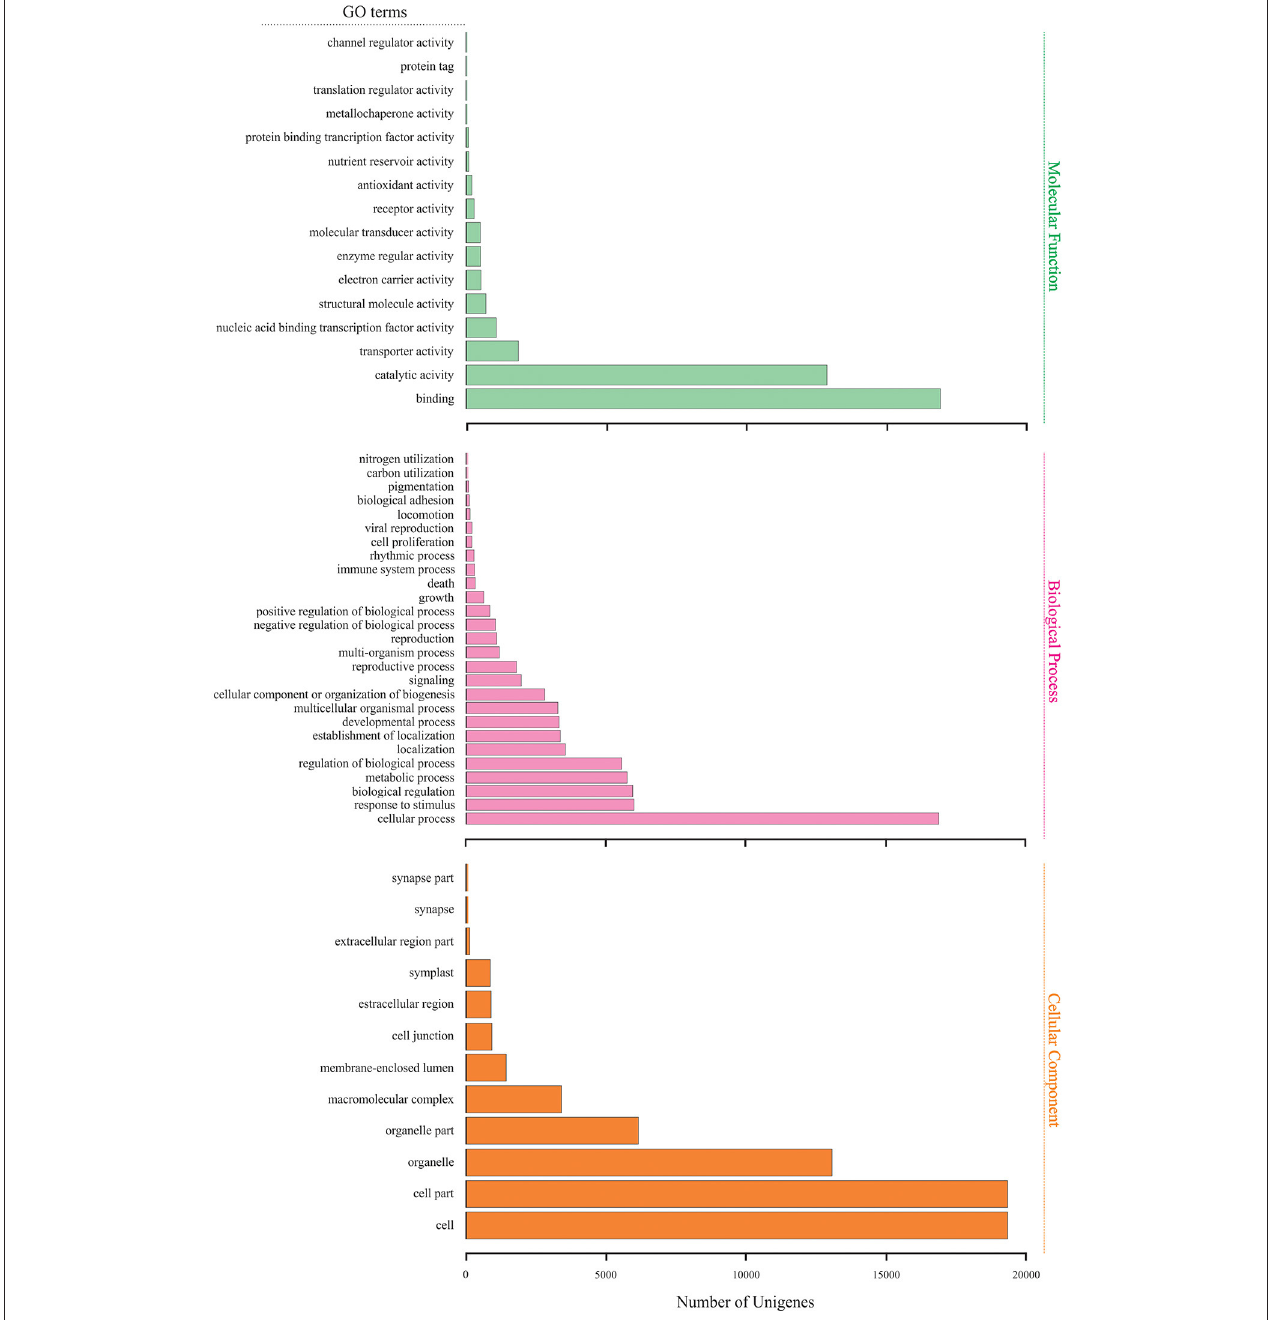
FIGURE 3 | Gene Ontology annotation for all assembled unigenes in the M. glaucescens transcriptome.